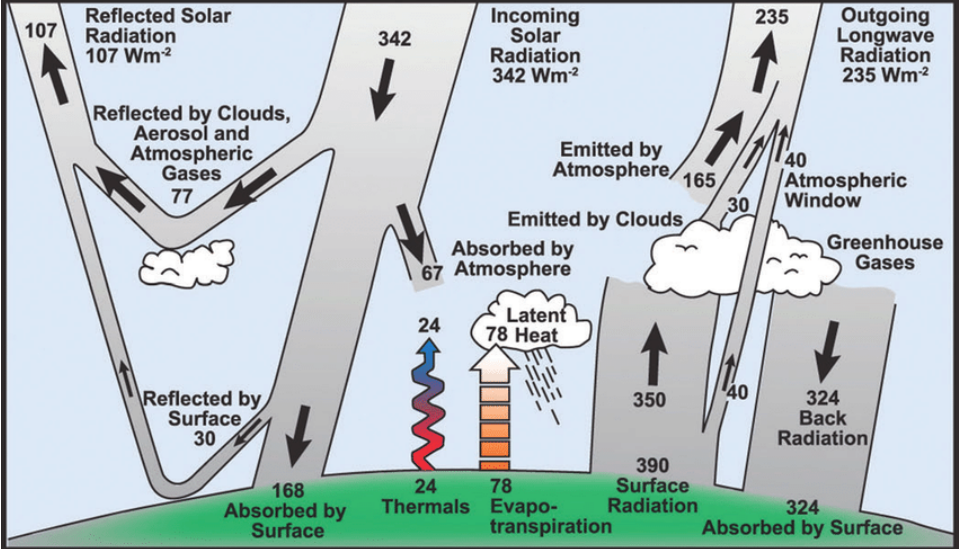
Figure 3. The Earth’s annual and global mean energy balance